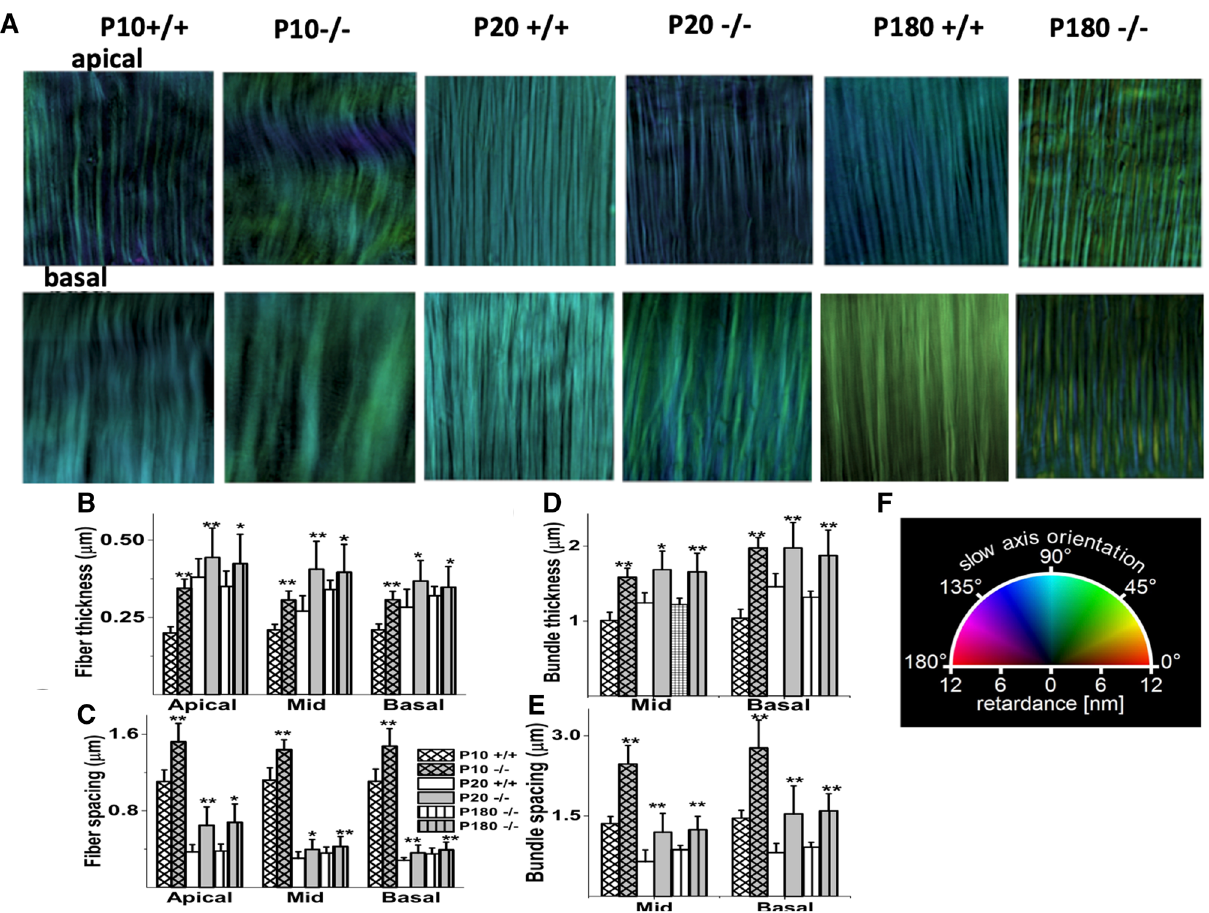
Figure 4. Changes in BM structure at different stages of development between wild type and Emilin2 −/− mice. ( A ) Examples of LC-PolScope images of collagenous fibers in unfixed BM preparations at P10, P20 and P60 from the wild type and emi-2 −/− cochlea. Top row corresponds to the ~ 7 kHz apical region, The bottom row corresponds to the ~ 60 kHz basal region Sample size shown is 10 × 10 μm. Similar fiber colors indicate uniform alignment; varied colors indicate nonuniformity. ( B ) Fiber thickness in apical, midturn and basal regions of -/- BM all increase significantly (as indicated by asterisks, see below) in size with age compared to emilin +/+ BM (as indicated by different column hatchings, see key for postnatal ages P1, P20, P180). ( C ) Fiber spacing is significantly higher in in apical, midturn and basal regions in emilin -/- compared to emilin +/+ BM. ( D ) Bundle thickness in apical, midturn and basal regions of emilin -/- BM all increase significantly in size with age compared to + / + BM. Bundles were not observed in apical turns. ( E ) Bundle spacing is significantly higher in in apical, midturn and basal regions in emilin -/- compared to emilin +/+ BM. ( F ) Color wheel shows a visual vectorial representation of orientations. A color wheel correlates the pseudo colors and the optical axis orientation. The reference (zero degrees) is the longitudinal axis of basilar membrane or X axis when you align the images of fibers along Y axis. Similar fiber colors indicate uniform alignment; color variations indicate nonuniformity in alignment. The measurements used for ( C )–( F ) were derived from measuring 200 samples for each age and location, using BM samples from six cochleae (3 mice) per age group, means ± SD. , * p < 0.001 and ** p < 0.0001, two-tailed unpaired t test comparing measurements taken at different ages with